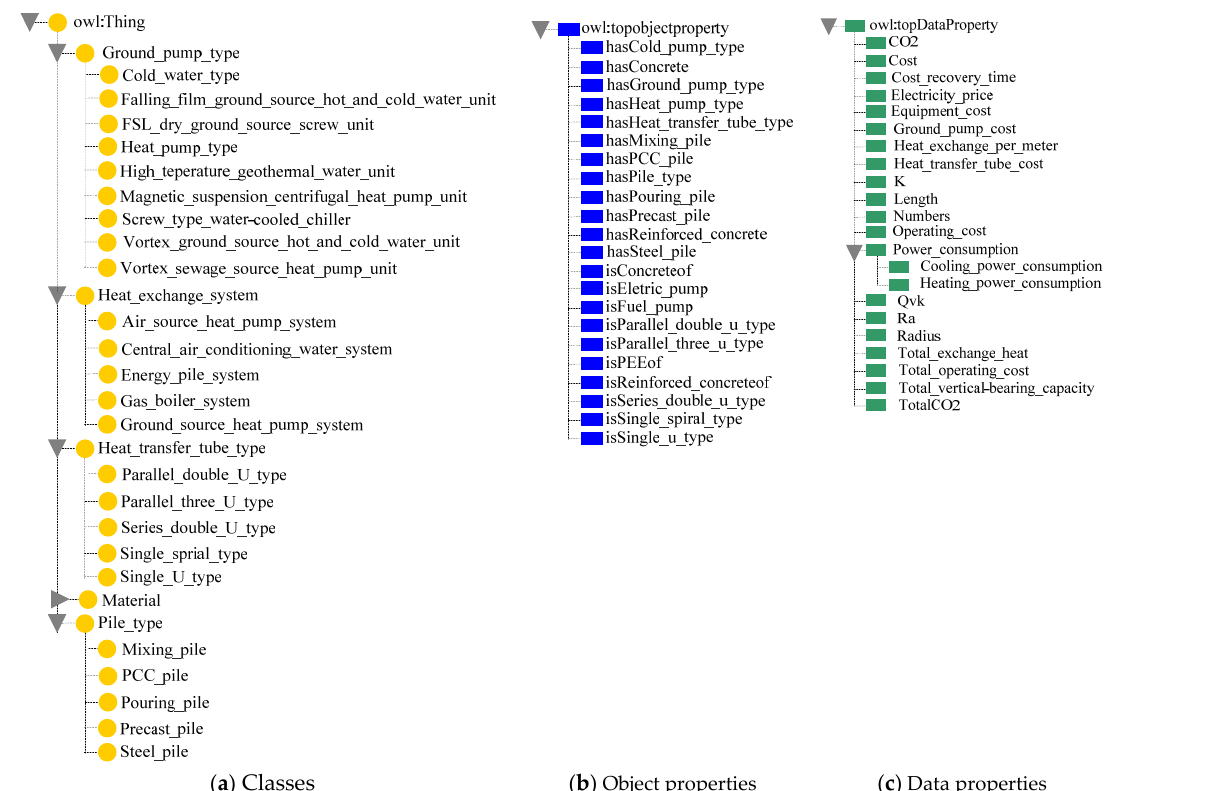
Figure 4. Procedure of ontology development for the EPS.